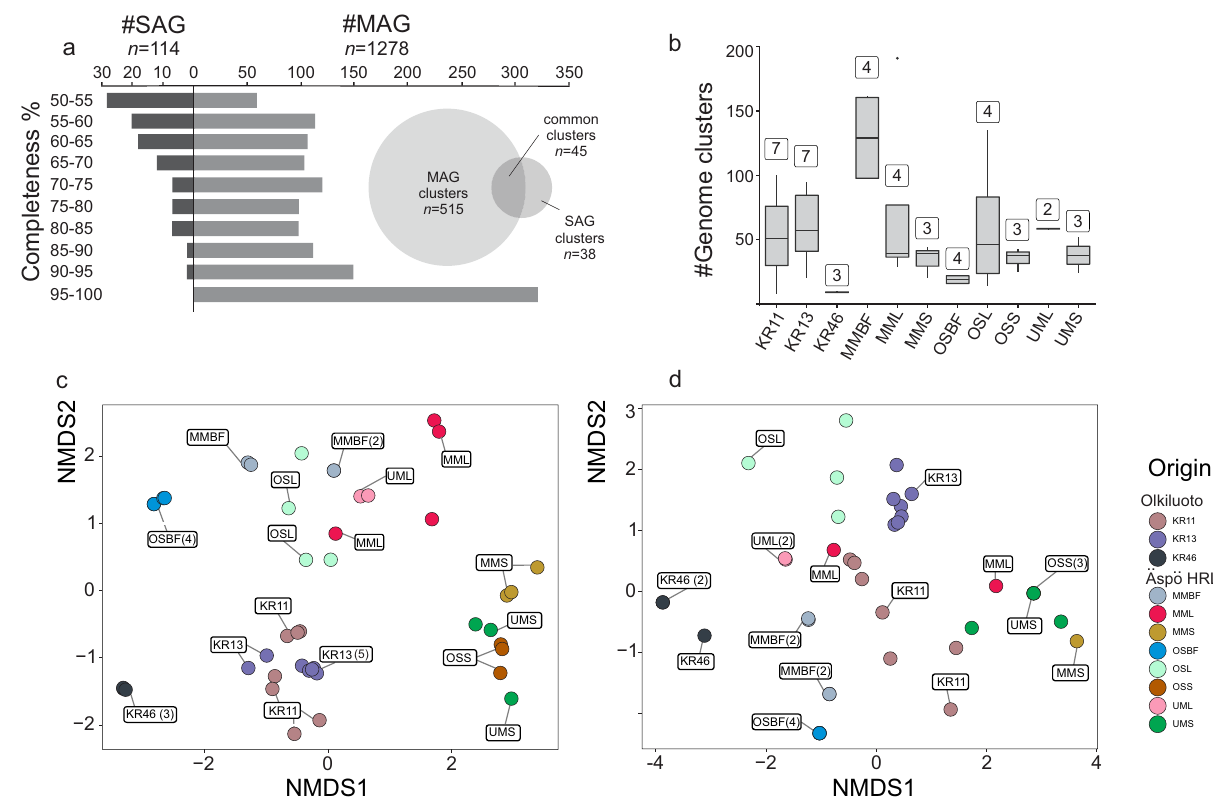
Fig. 1 Overview of the FSGD MAGs and SAGs. Statistics of the metagenome-assembled genomes (MAGs) and single-cell ampli fi ed genomes (SAGs) of the Fennoscandian Shield Genomic Database ( a ). The number of genome clusters present in borehole samples (centerline, median; hinge limits, 25 and 75% quartiles; whiskers, 1.5x interquartile range; points, outliers). Numbers on top of each box plot represent the number of metagenomes generated for borehole samples ( b ). NMDS plot of unweighted binary Jaccard beta-diversities of presence/absence of all FSGD reconstructed MAGs/SAGs ( c ) and MAG and SAG clusters belonging to the common core microbiome present in both Äspö HRL and Olkiluoto ( d ). Numbers in the parenthesis show the number of overlapping points. The data used to generate these plots are available in Supplementary Data 4 and the Source